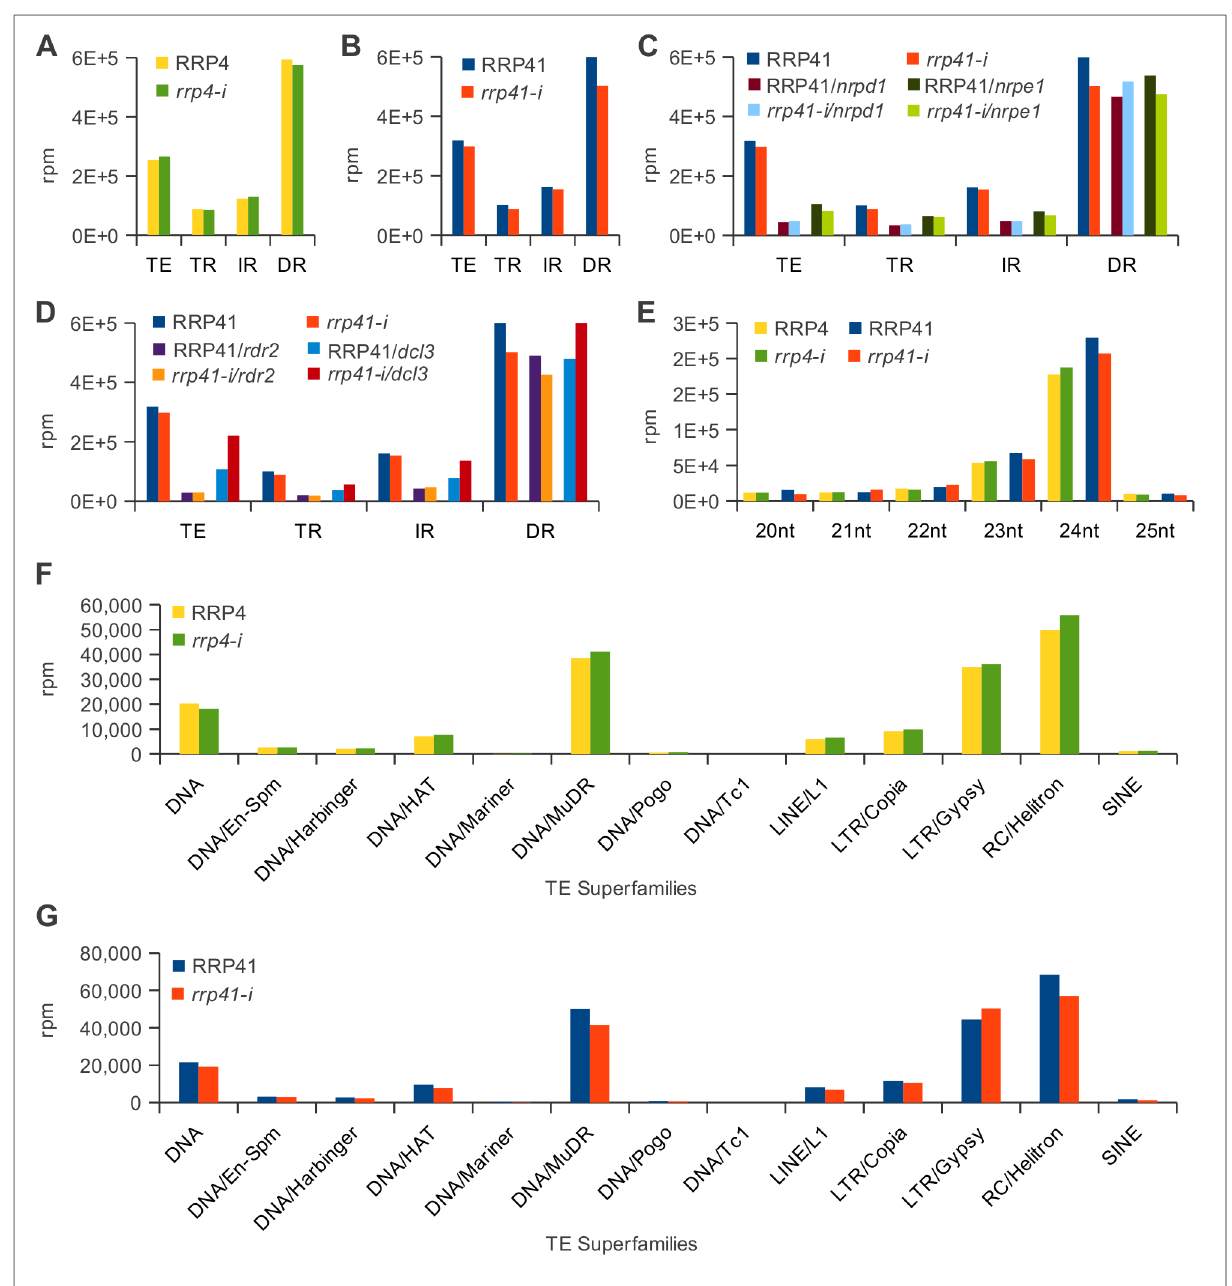
Figure 2. Characterization of 20–25 nt smRNAs corresponding to transposons and repeats in exosome and RdDM mutants. (TE=transposable element; TR=Tandem repeat; IR=Inverted repeat; DR=Dispersed repeat) (A) Results of depletion of exosome rrp4 subunit. (B) Results of depletion of rrp41 exosome subunit. (C) Results of depletion of rrp41 in nrpd1 and nrpe1 genetic backgrounds. (D) Results of depletion of rrp41 in dcl3 and rdr2 mutants. (E) Characterization of smRNAs mapped to repeats and transposable elements in rrp4-i and rrp41-i libraries profiled based on the reads length (F, G). Classification of 24 nt smRNAs corresponding to the different superfamilies of TEs in rrp4-i (F) and rrp41-i mutants (G)